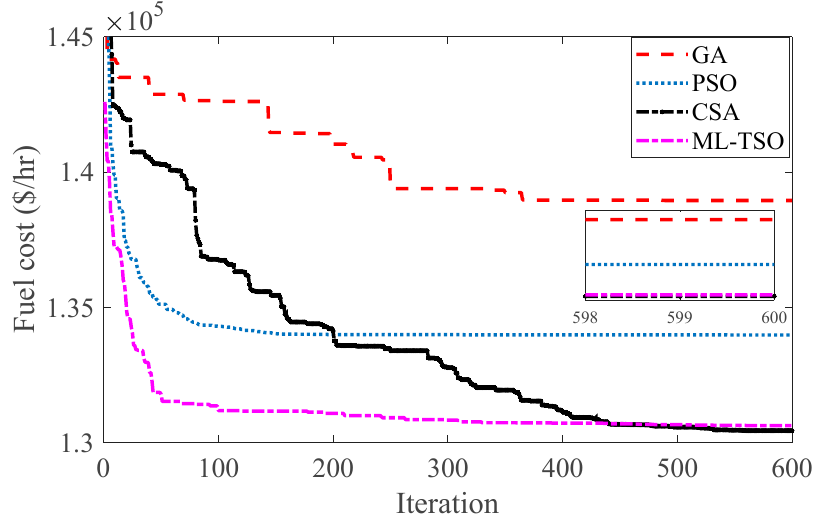
Figure 11. Convergence performance of the CSA, the GA, and the PSO in the case of the 118-bus system.